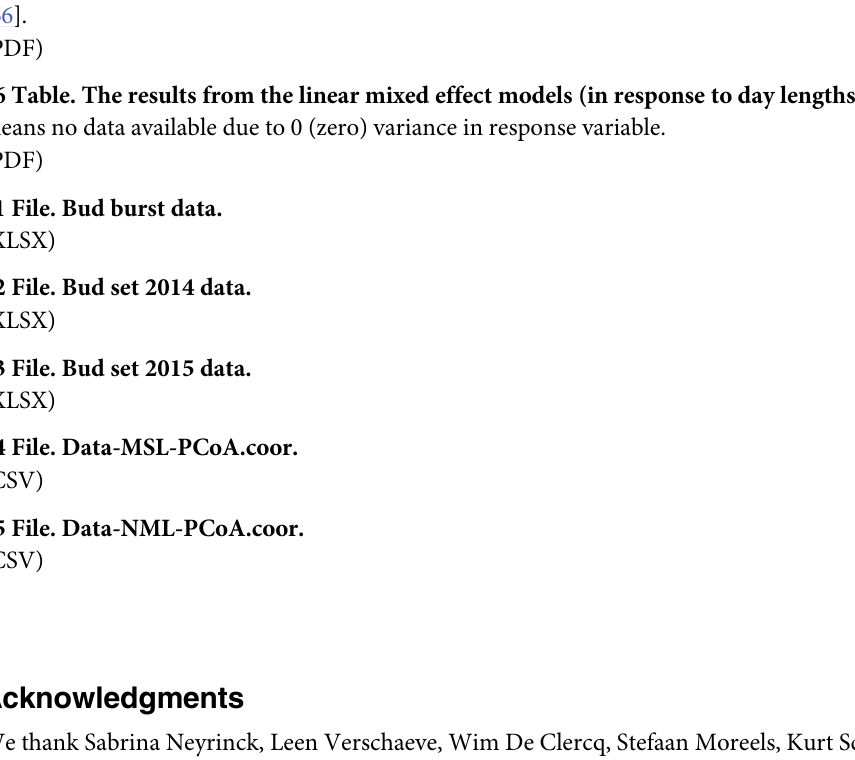
S6 Fig. Representation of Principal Coordinate Analysis (PCoA) for methylated (A) and non- methylated (B) loci. Samples are grouped per clone (countries are here BE = Belgium, FR = France, ES = Spain, IT = Italy and SE = Sweden). The first two coordinates (PCO1 and PCO2) are shown with the percentage of variance explained by them. Different point types represent individuals from different groups. S1 Table. Description of the scoring systems of bud burst and bud set in poplar cuttings based on visual observation. S2 Table. Number of individuals collected and monitored from respective genotypes and country for determination of DNA mathylation and bud phenology (bud burst and set). S3 Table. List of the microsatellite markers used for the genotype identification. TA; annealing temperature, MP: multiplex. S4 Table. Primer combinations used, number of loci and estimated genotyping error rates. (DOCX) S5 Table. The results from the linear mixed effect models (in response to temperature vari- ables and stem diameter). NA means no data available due to 0 (zero) variance in response variable. We used lmerTest package to extract the ρ values from the linear mixed effects models [66]. S6 Table. The results from the linear mixed effect models (in response to day lengths). NA means no data available due to 0 (zero) variance in response